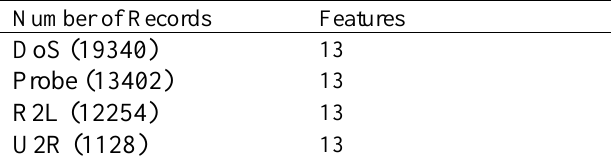
Number of records and features